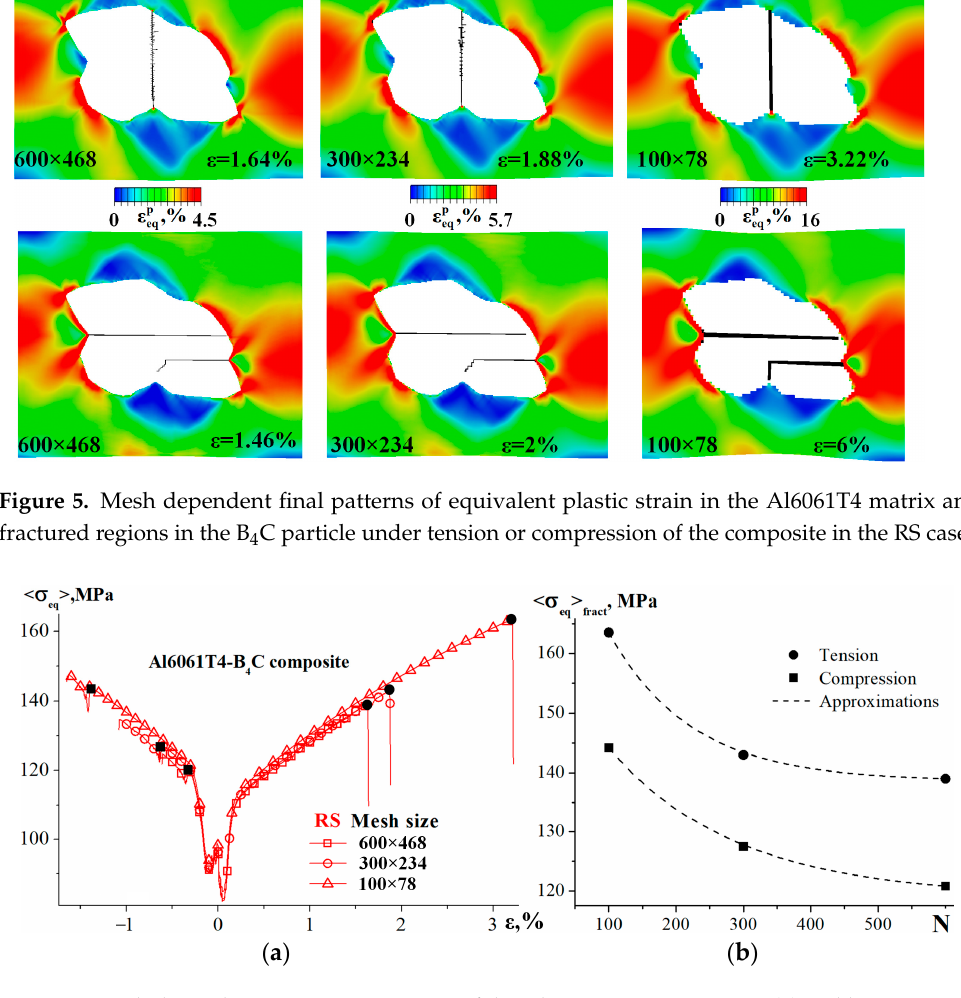
Figure 6. Mesh dependent stress–strain curves of the Al6061T4-B 4 C composite ( a ) and homogenized stress at the fracture onset vs. the number of mesh cells in the X 1 -axis ( b ). stress at the fracture onset vs. the number of mesh cells in the X 1 -axis ( b